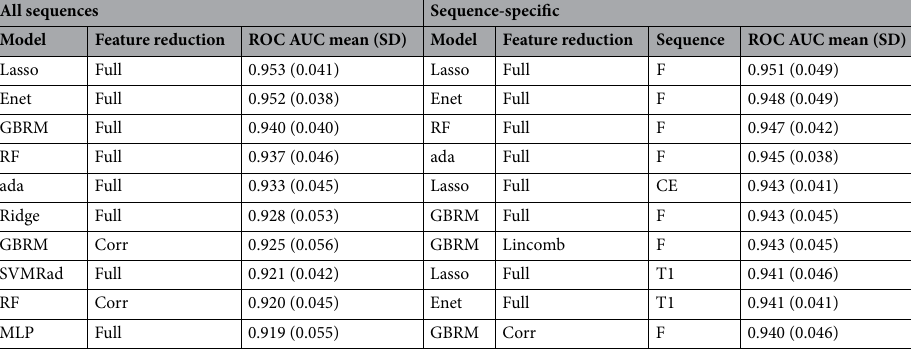
Table 2. Top ten best performing models using all sequence and sequence-specific features sets ordered by ROC AUC. Enet: elastic net; Lasso (least absolute shrinkage and selection operator; GBRM: generalized boosted regression model; RF: random forest; ada: boosting of classification trees with adaBoost; SVMRad: SVM with a radial kernel; MLP: multi-layer perceptron; full: full feature set; corr: High correlation filter; lincomb: linear combinations filter; F: FLAIR; CE: T1-CE.